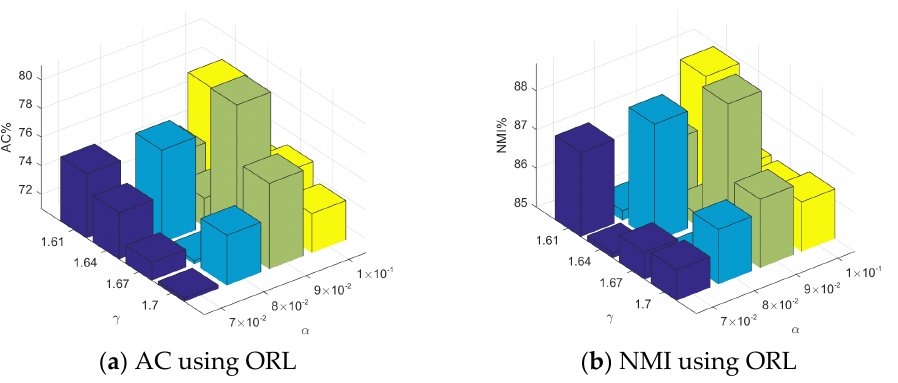
Figure 5. The AC and NMI values when using the ORL dataset.